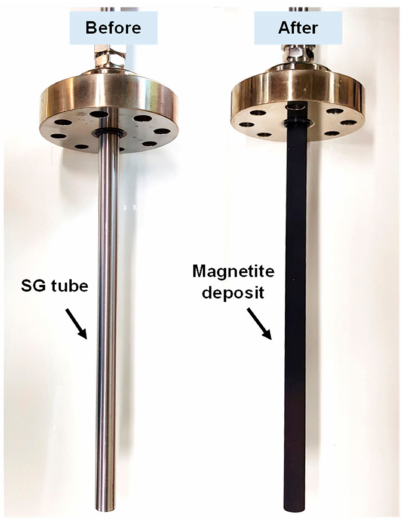
Figure 5. Photo of SG tube (Alloy 690TT) before and after the magnetite deposition